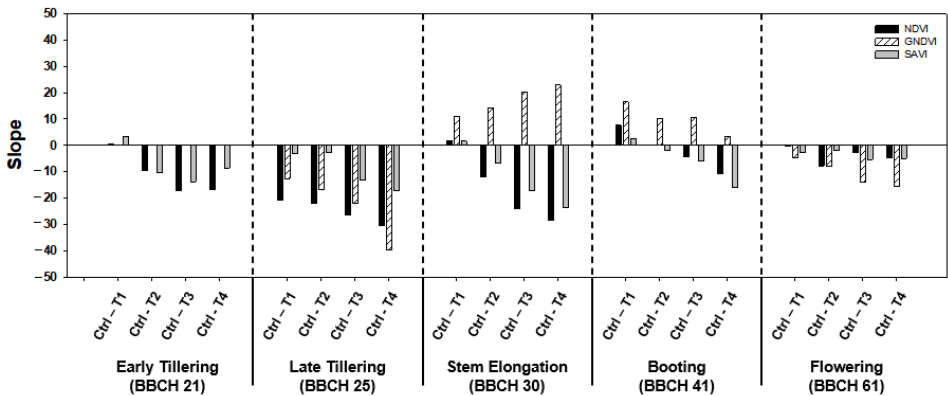
Figure 4. The slope (sensitivity) value of the normalized difference vegetation index (NDVI), green normalized difference vegetation index (GNDVI), and soil-adjusted vegetation index (SAVI) according to toluene exposure level at five growth stages. The outliers are excluded from this graph.